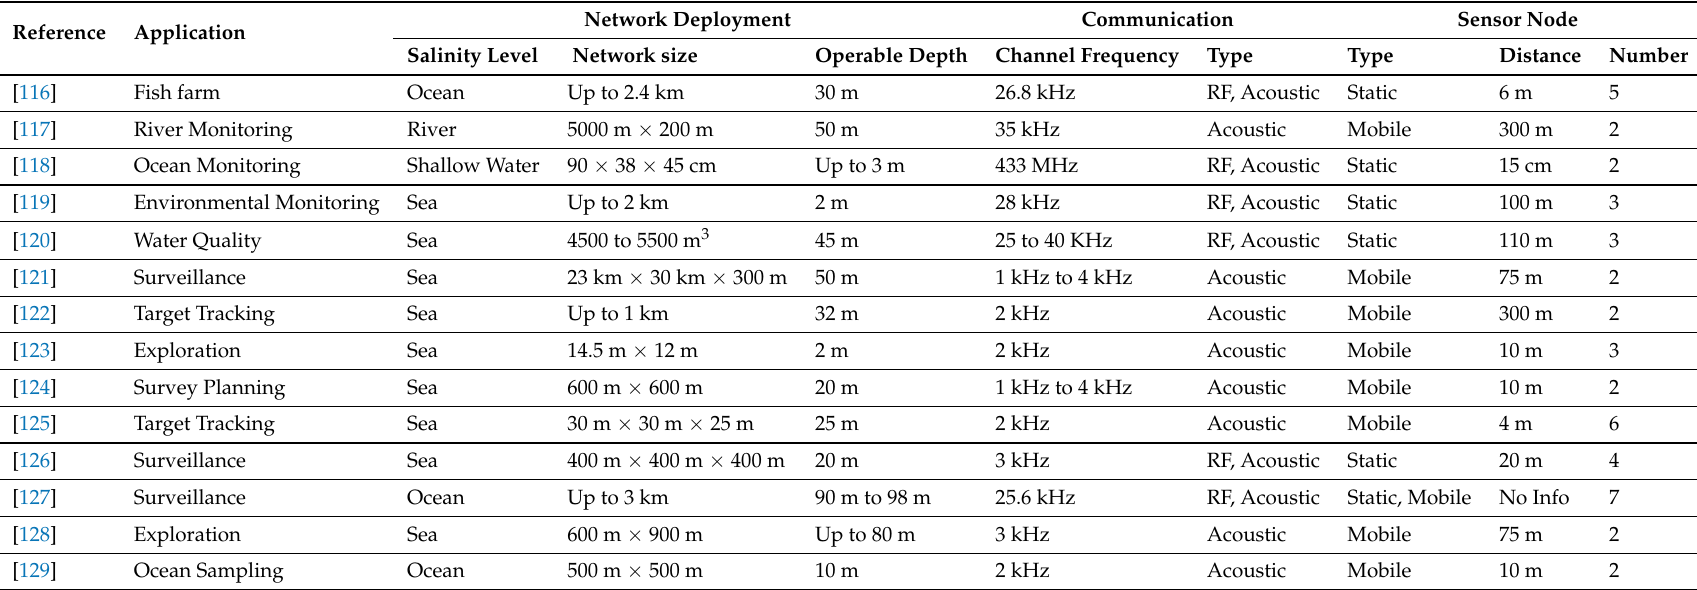
Table 7. Comparison of Various Underwater Wireless Sensor